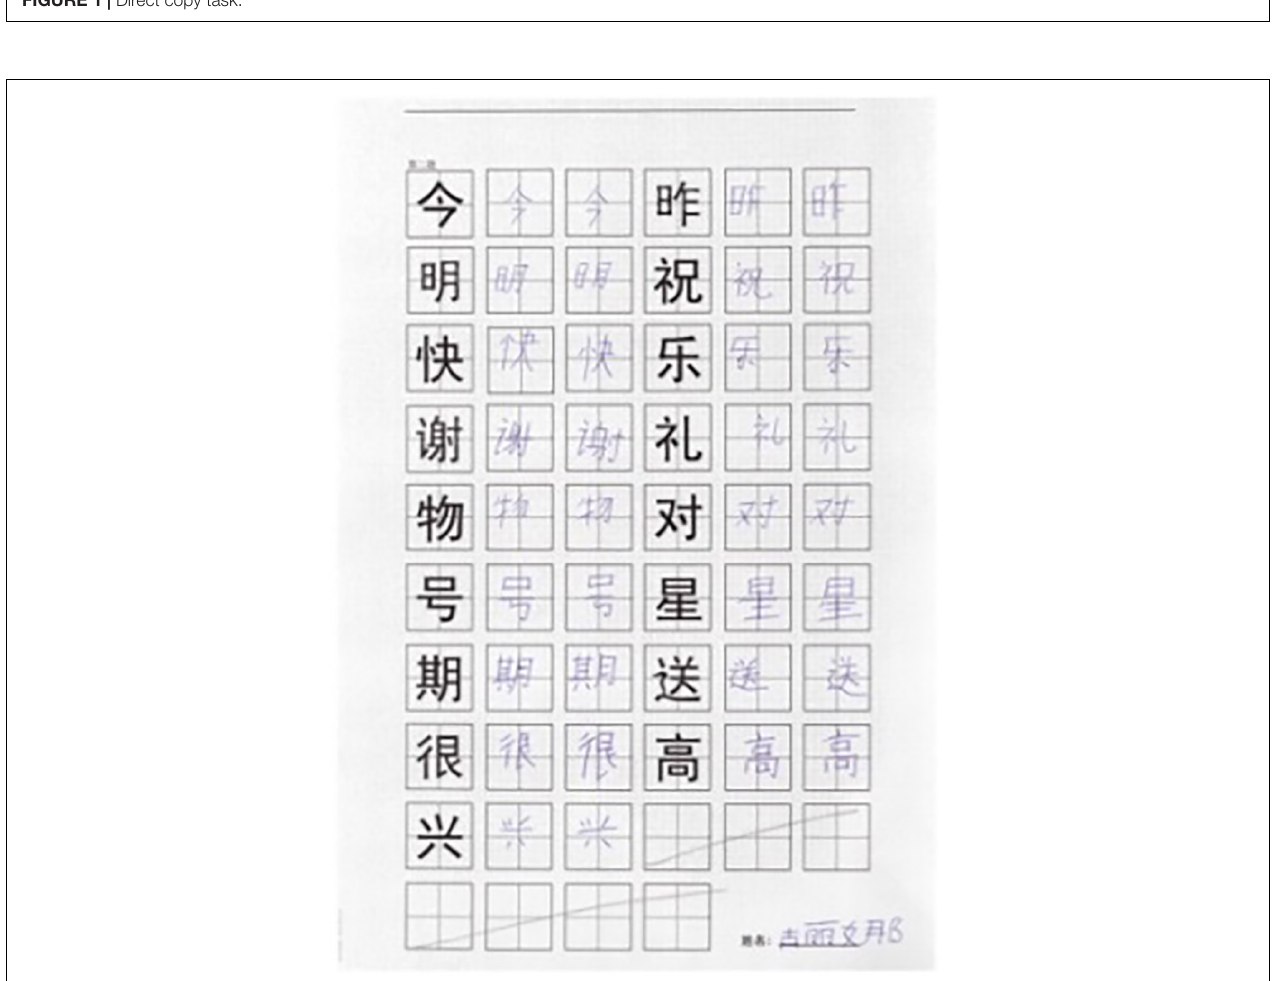
FIGURE 1 | Direct copy task.